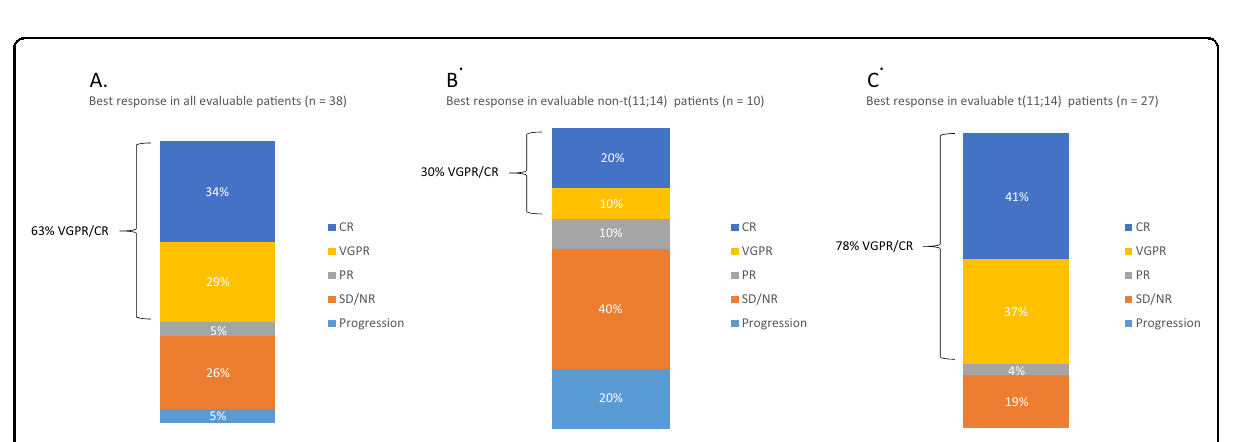
Fig. 3 Hematologic response rate. A All evaluable patients, B response in non-t(11;14) patients, C response in t(11;14)